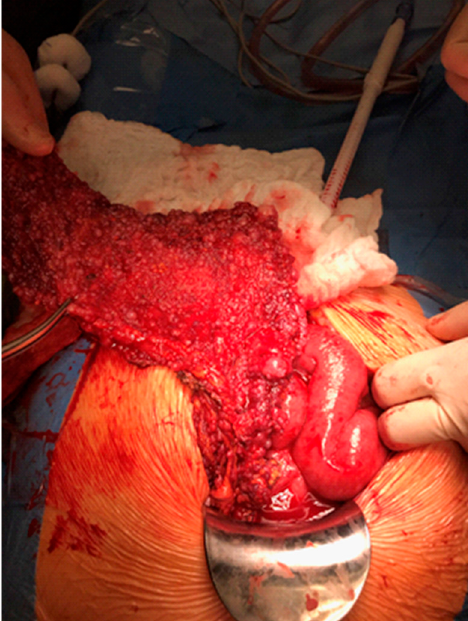
Figure 1. High-grade ovarian cancer‚ omental cake-like metastasis to the omentum in a 68-year old female; FIGO IIIC; 2019. University Oncology Center, Bialystok,